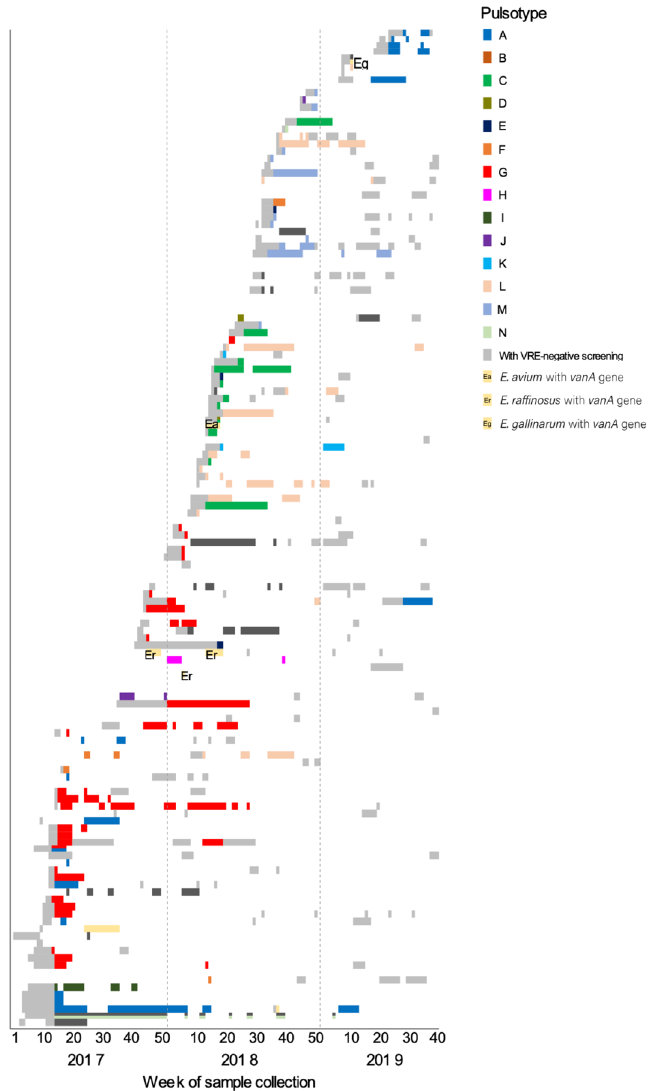
Figure 3. Temporal occurrence of vancomycin-resistant enterococci (VRE) and pulsotypes among VRE patients in ward A. Length of bar represents duration of